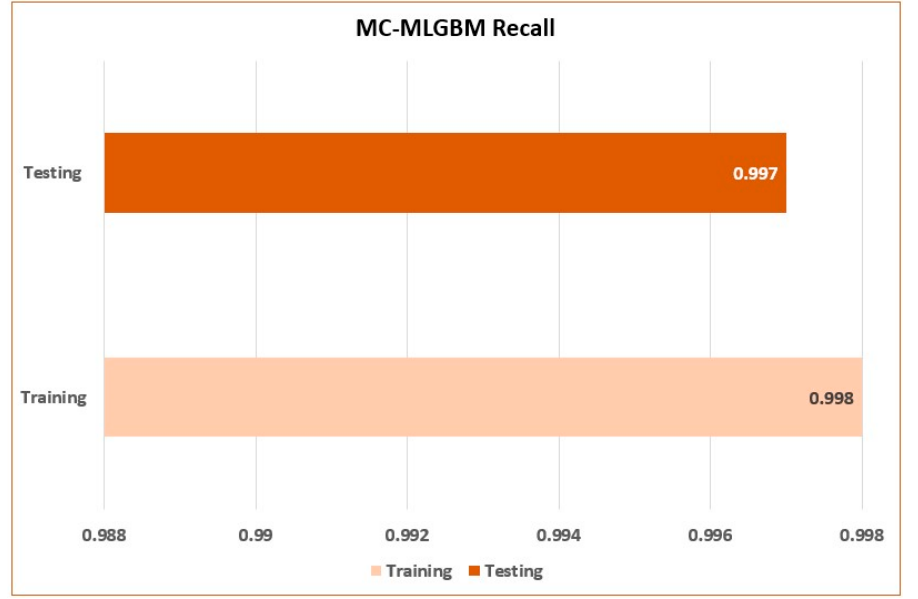
Figure 7. Training and testing recall of the proposed model. Table 4. Performance Analysis of the Proposed Model.